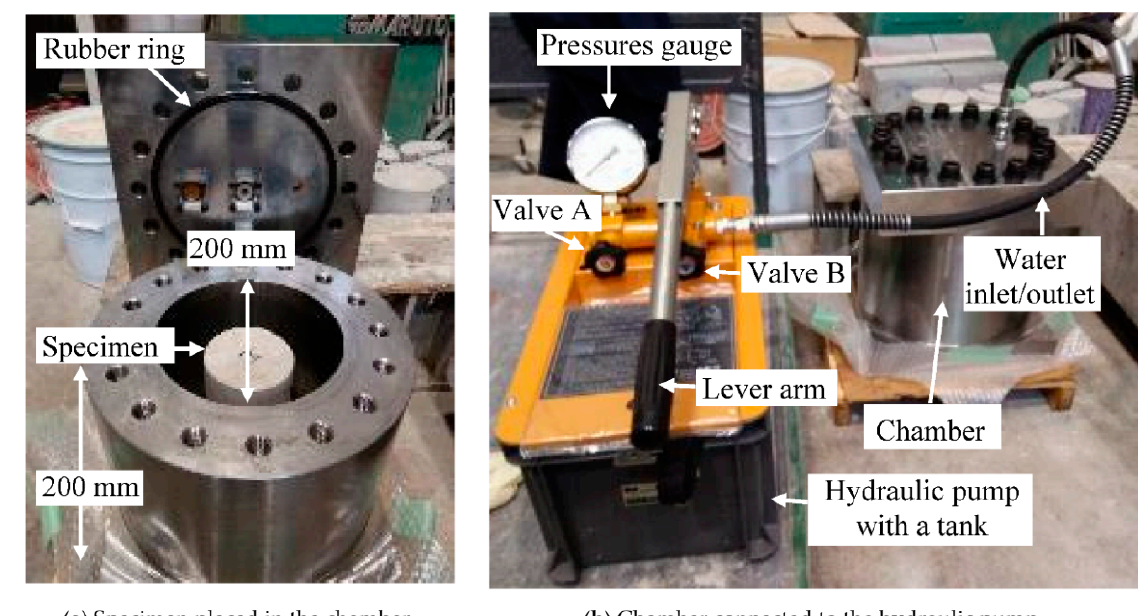
Figure 1. High-water-pressure